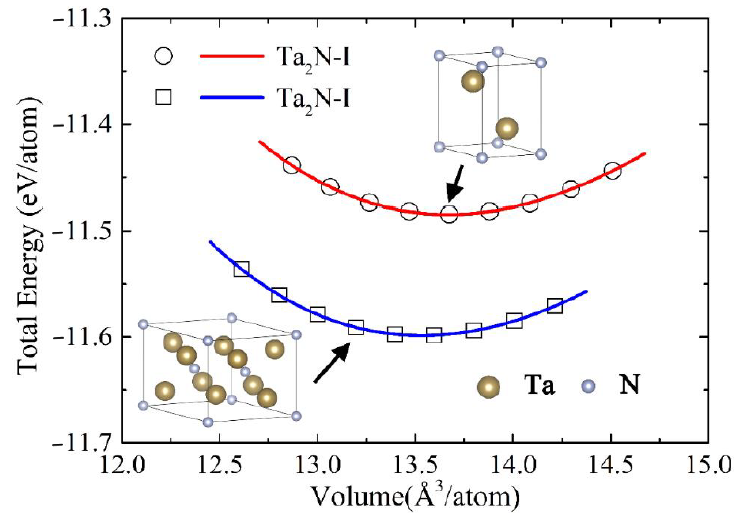
Figure 2. Equation of state fitting curve of energy-volume ( E-V ) for Ta 2 N-I and Ta 2 N-II.